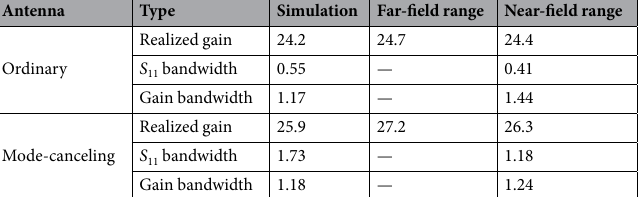
Gain bandwidth 1.18 — 1.24 Table 1. Comparison of maximum realized antenna gain [dBi], − 10dB reflection ( S 11 ) bandwidth [GHz], and 3 dB realized gain bandwidth [GHz] of the ordinary ( l main = l sub = 0) and mode-canceling ( l main = l sub = + 1) reflectarray antennas. The realized antenna gains were computed and measured at 18 [GHz]. The reflection coefficients were measured using a network analyzer (Anritsu 37397